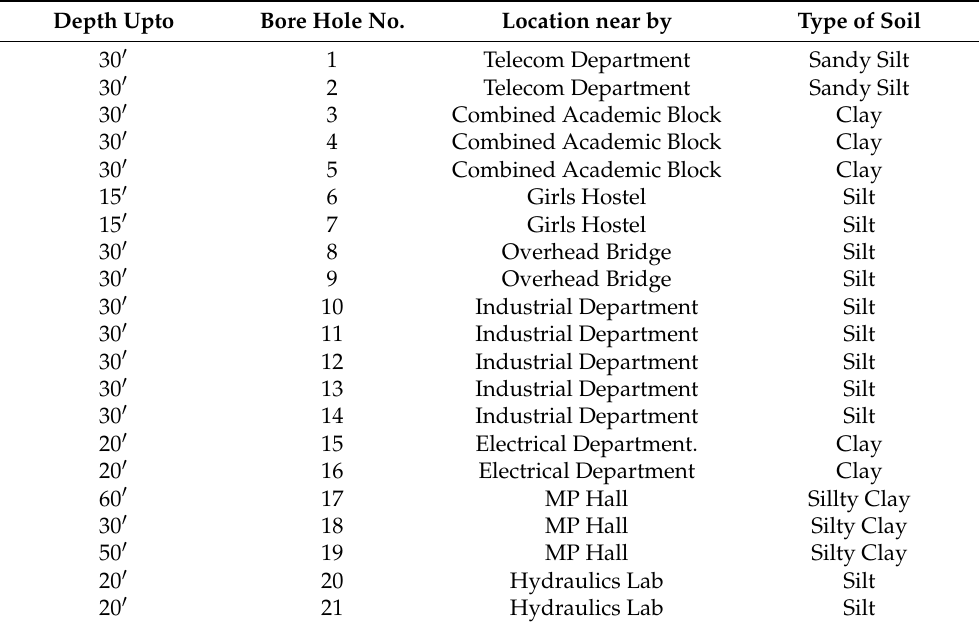
Table 2. Soil classification of